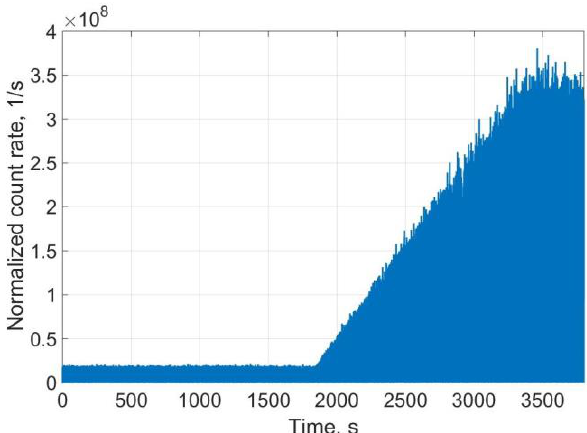
Fig. 7. Normalized count rate of the MSV chain while the reactor power